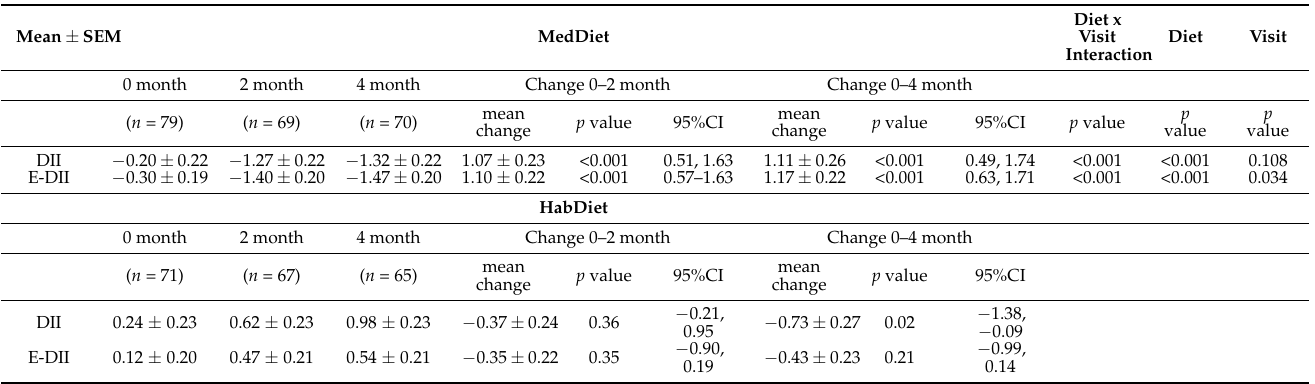
Showing statistical analysis by linear mixed effects model with a diet x time interaction comparing MedDiet and HabDiet across 3 time points. Mean values ± SEM. DII, dietary inflammatory index; E-DII, dietary inflammatory index adjusted for energy; MedDiet, Mediterranean diet; HabDiet, habitual diet; 95%CI, 95% confidence interval.